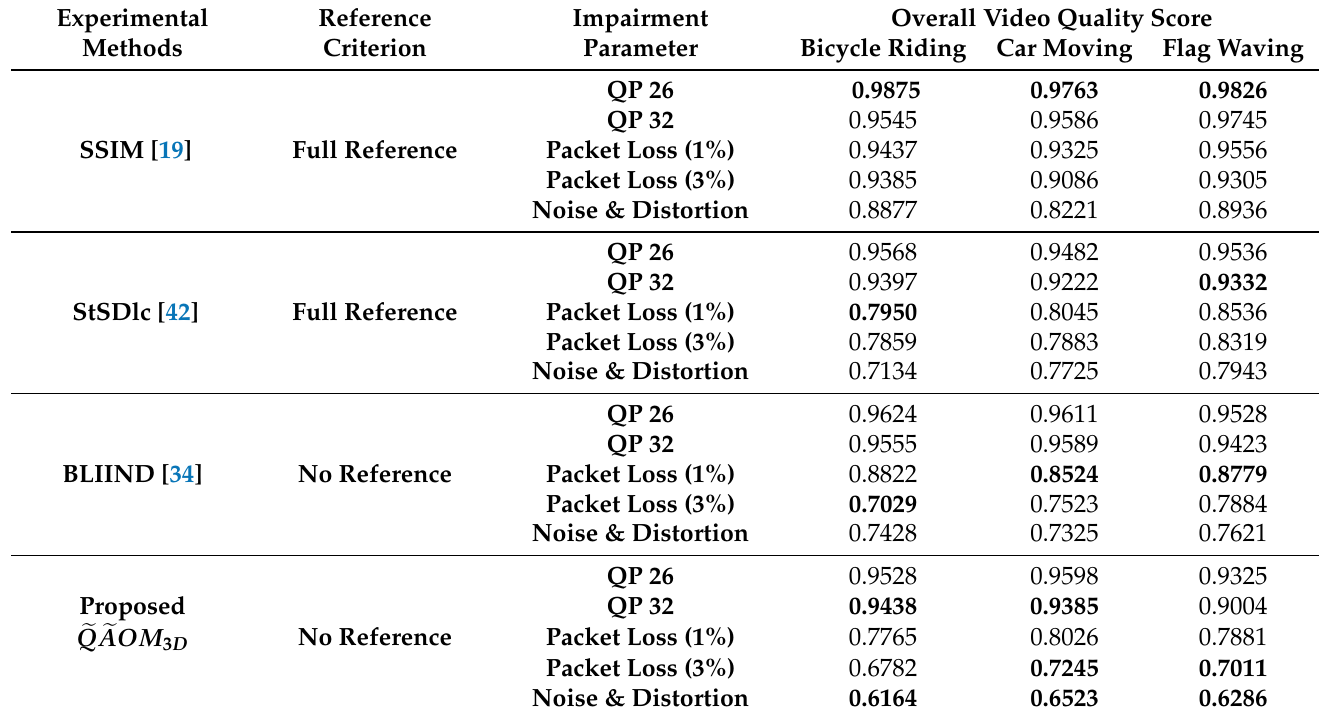
Table 4. Comparison of quality scores from the proposed and different prominent